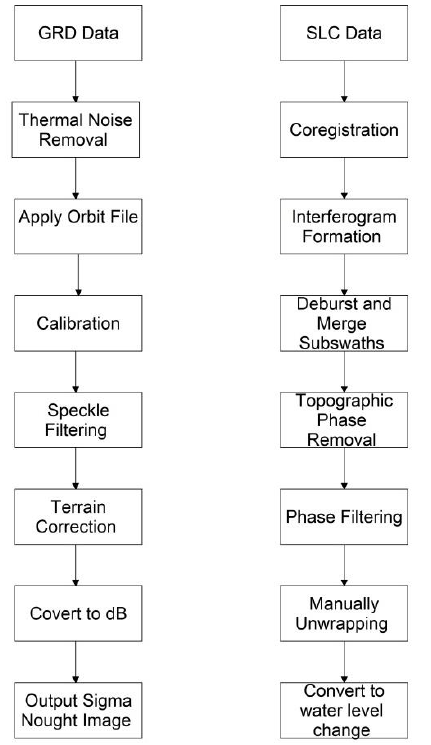
Figure 4. The results for both extent and magnitude mapping are shown in Session 5.